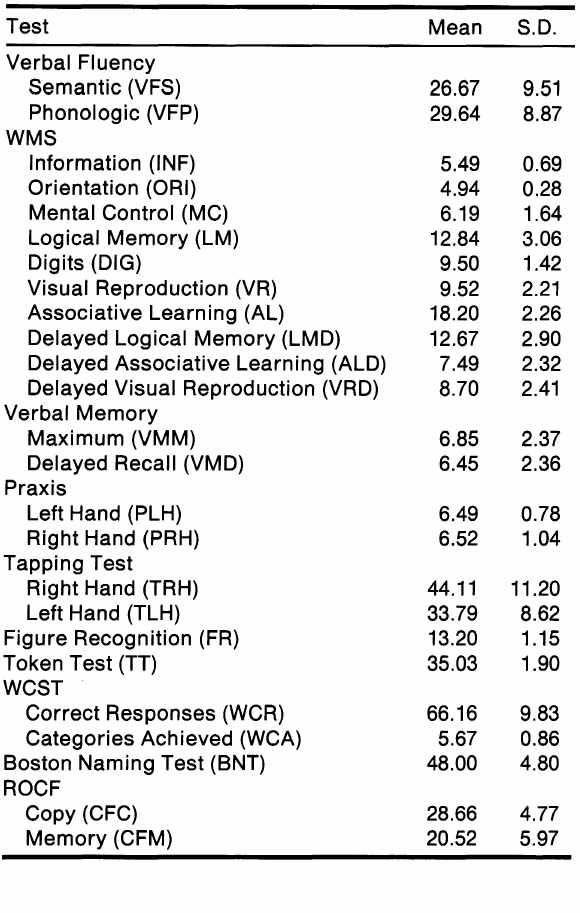
TABLE IV. Factor analysis of the neuropsychological battery